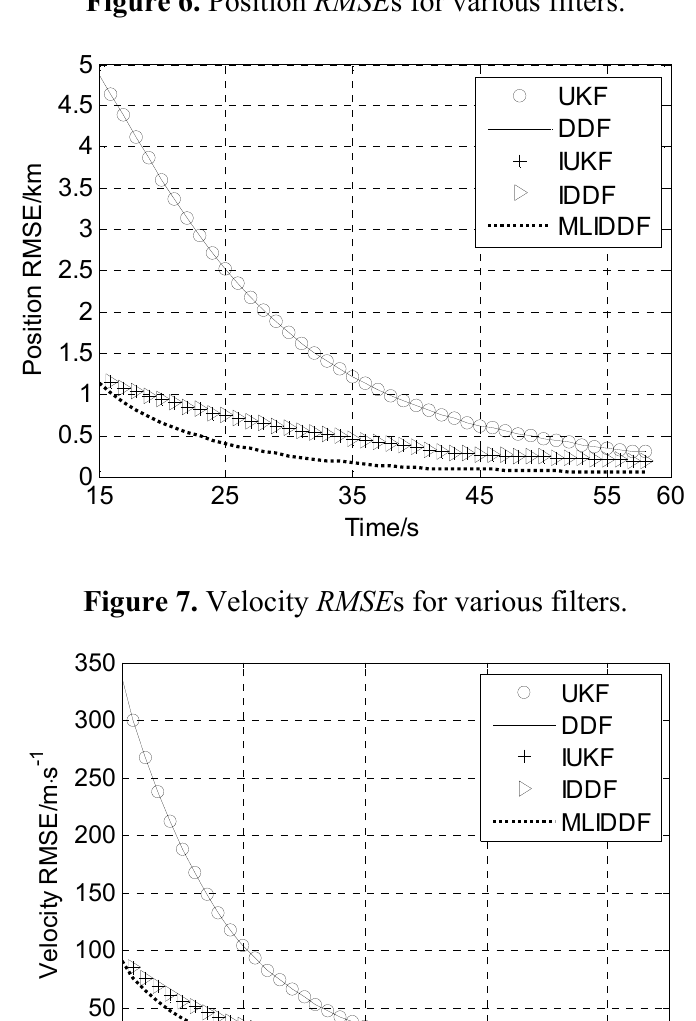
Figure 6. Position RMSE s for various filters.